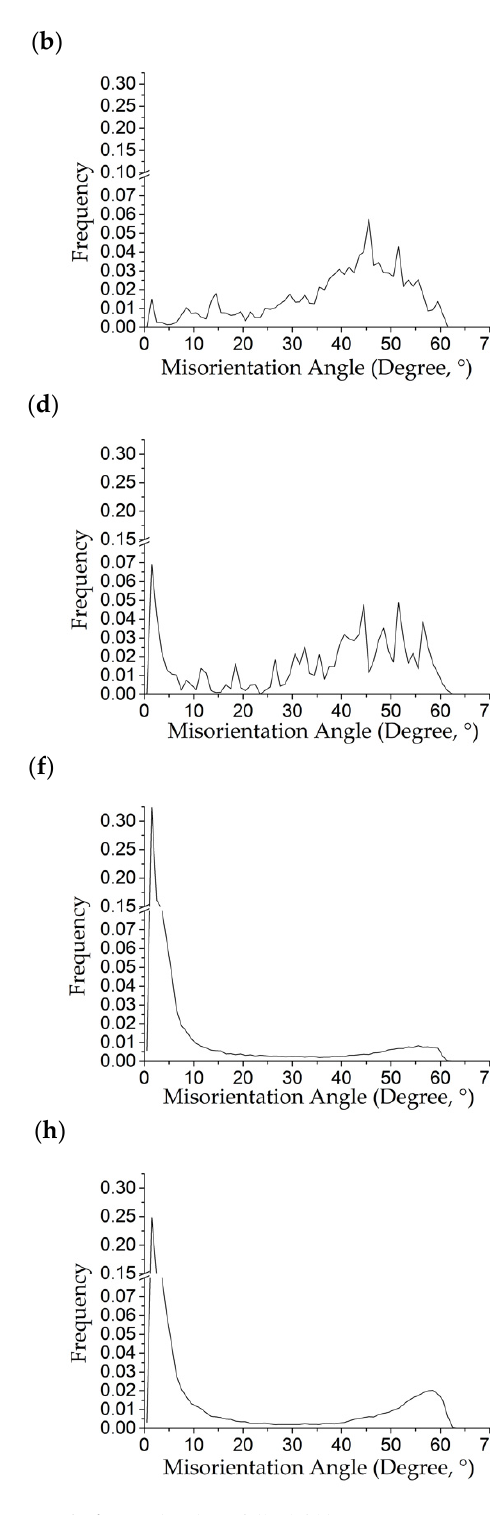
Figure 7. EBSD analysis results: ( a , c , e , g ) inverse pole figure (IPF) and ( b , d , f , h ) misorientation angle distribution for ( a , b ) CF50, ( c , d ), RF50, ( e , f ) HF50, and ( g , h ) HF62 after T73 heat treatment. After T73 treatment, dispersoids were produced in the over-aged conditions and these became stable in size. These dispersoids are shown in Figure 8a,b for RF50 and HF50, respectively. The EDX analysis showed the constituted elements of dispersoids, as listed in Table 3. They were Mg(Zn,Cu) 2 , S-Al 2 CuMg and T-Al 2 Mg 3 (Cu,Zn) bases, as described by Hua et al. [25,26]. Angella and co-workers studied the dispersoids